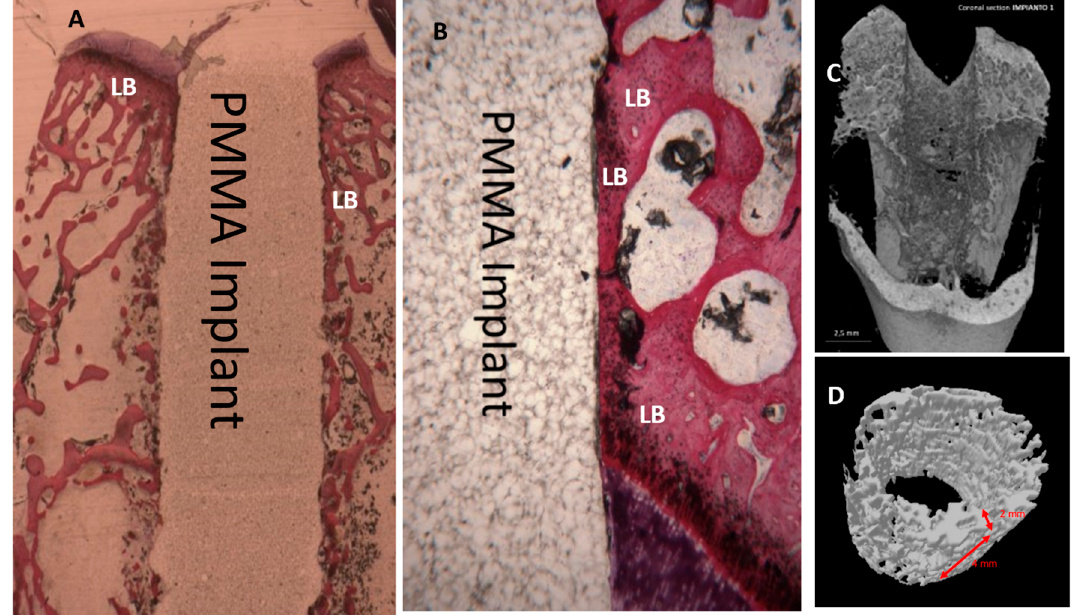
Figure 4. PMMA implant. ( A ) Lamellar bone (LB) in direct contact with the implant is present. Acid fuchsin-toluidine blue 12 × . ( B ) Mature bone (LB) in direct contact with the implant, no osteoblast activity is present. No degradation layers or cracks nor detachment of fragments are observed. Acid fuchsin-toluidine blue 100 × . ( C , D ) Micro-CT shows a mineralized bone with small medullary space.